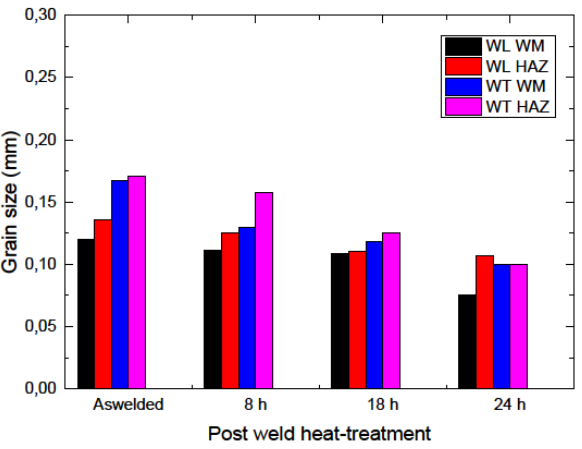
Figure 8: Average grain size measurement for as-welded AL6061 and AL6061-T6 especially for WM and HAZ.